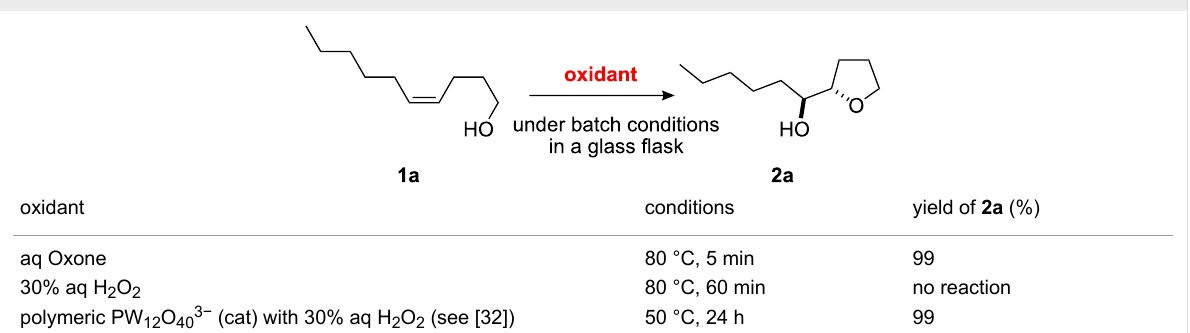
Table 1: The oxidative cyclization of an alkenol 1a with Oxone under batch conditions.